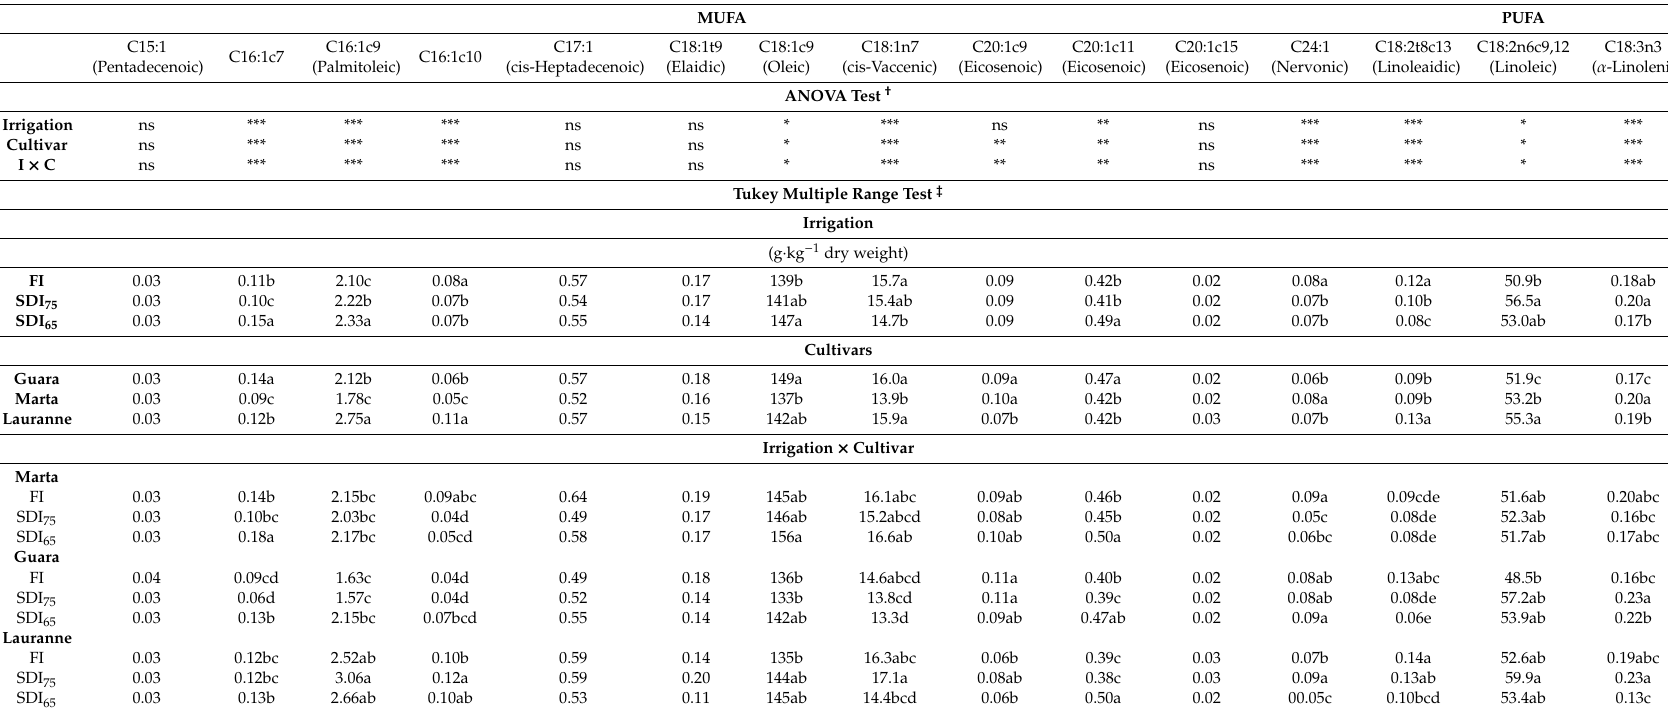
Table 7. Monounsaturated and polyunsaturated fatty acid (MUFA and PUFA) profile in raw almonds a ff ected by cultivar and irrigation dose.